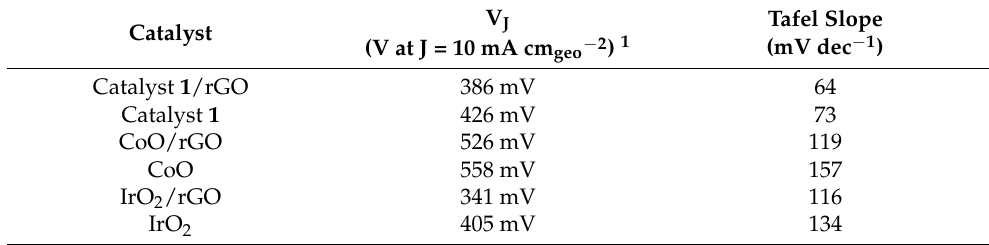
Table 1. Overpotential and Tafel slope of the electrocatalysts.